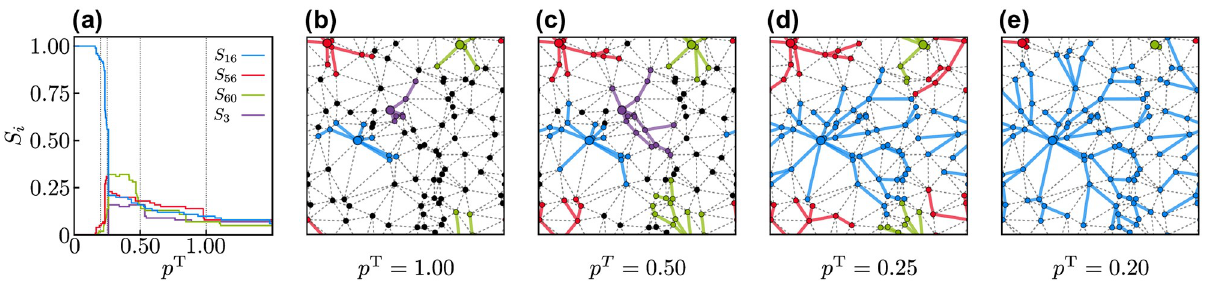
Fig 2. Cluster growth in the percolation model. (a) Evolution of the size S of four clusters measured by the production S of the clusters supplier i (the i i number of nodes relative to the size of the whole network). Every node in the network optimizes its costs to satisfy its demand as described in the main text. As the importance of transport costs p T decreases, nodes make external purchases and clusters (common markets) emerge where production is centralized at a single node k . As p T ! 0, only a single, global cluster with a central supplier k � = 16 and S 16 = 1 remains (blue line). (b-e) Snapshots of the network for different values of p T . The four clusters with centralized production shown in panel (a) are illustrated in their respective colors and the central supplier node is highlighted. Black nodes do not belong to any of these four clusters. Solid colored lines indicate active links in the transport network, dashed lines indicate potential transport links that are not used by the four large markets. Parameters are D = 1/ N , b 2 [0, 1] distributed uniformly at random and a = 10 − 3 . The planar network is created as the Delaunay triangulation from N = 100 points distributed uniformly at random in the unit square (see Methods for more